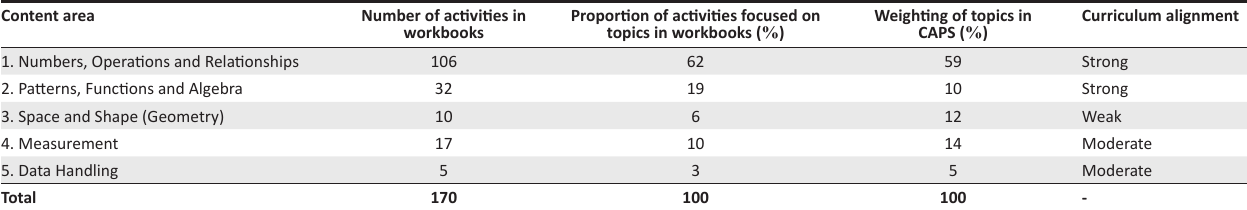
TABLE 6: Curriculum alignment in mathematics workbooks across content areas. Content